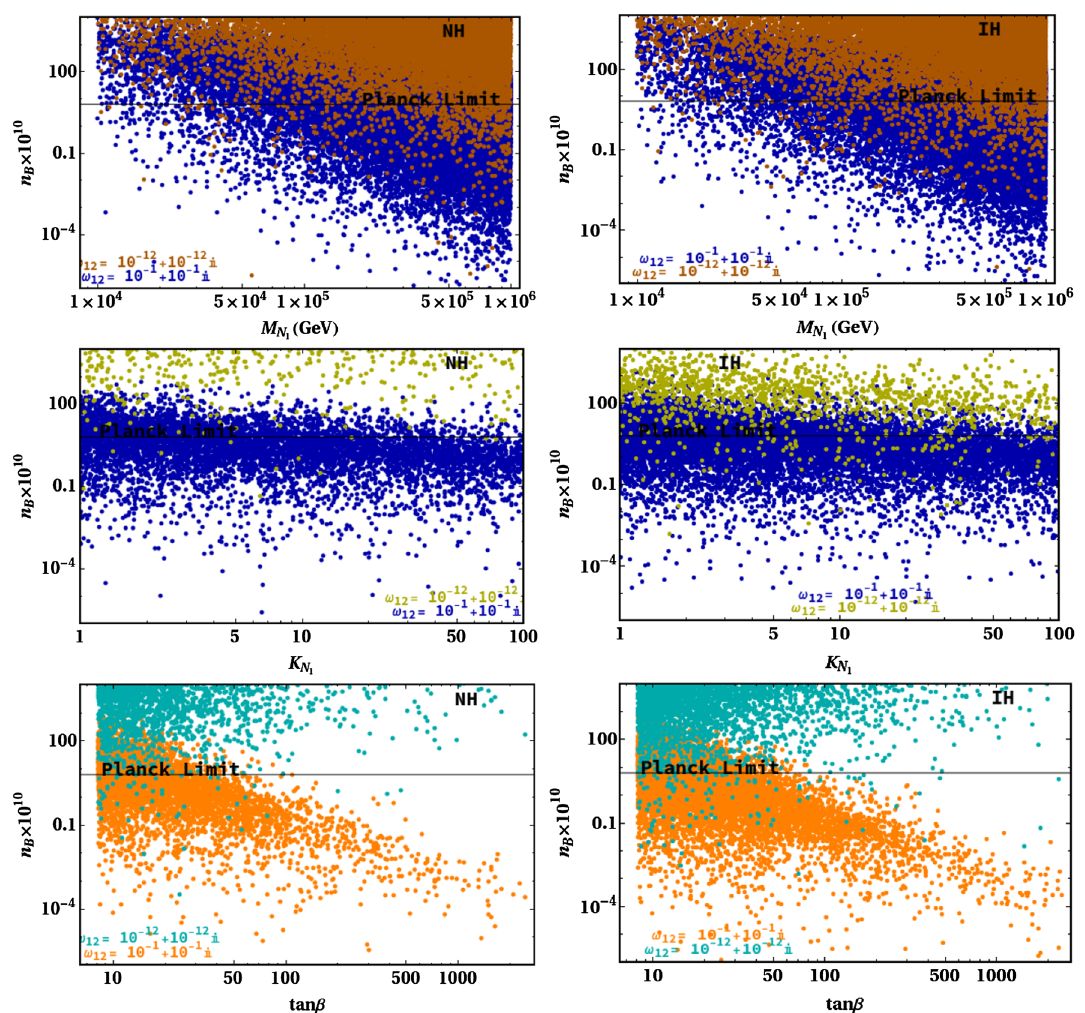
Fig. 2 BaryonasymmetryoftheUniverseasafunctionoflightestRHN ( N 1 ) is shown in the first row. The second and third row depicts BAU as a function of K N and tan β respectively. We take two different values 1